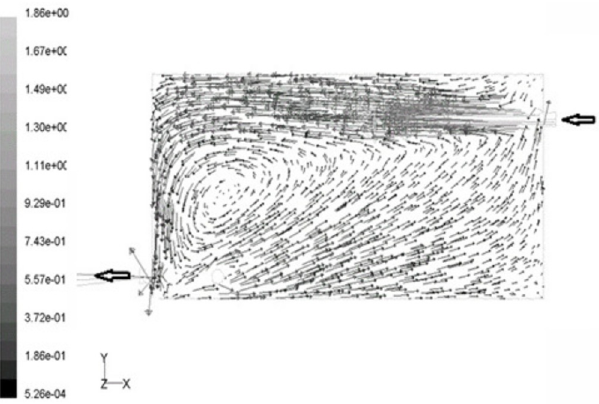
Figure 3. Velocity distribution in the longitudinal section containing axis of symmetry in the fermenter for volume flow Q = 30 dm 3 /min. and diameter of the inlet/outlet pipes d = 2.0